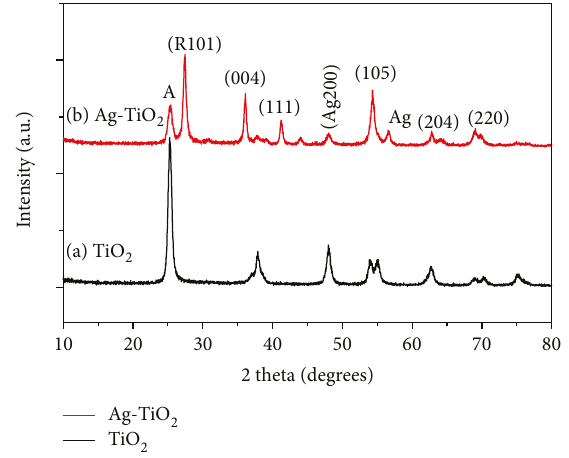
Figure 1: XRD patterns of (a) TiO and (b) Ag-doped TiO 2 2 nanoparticles. Figure 2: XRD patterns of (a) ZnO and (b) Ag-doped ZnO